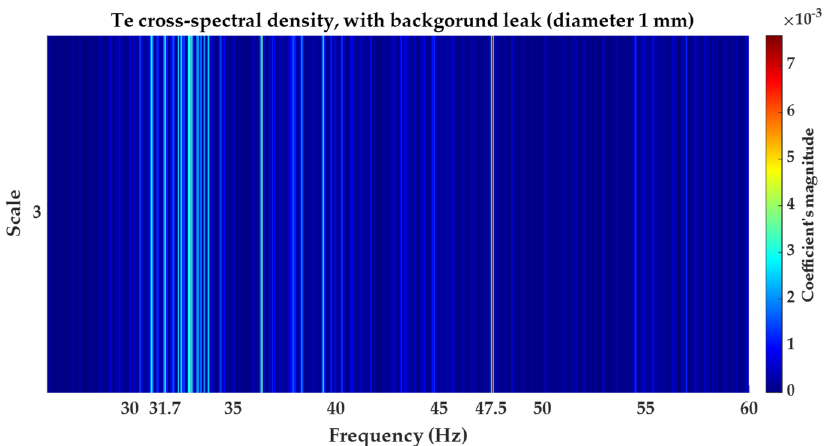
Figure 14 . 𝒯 (cid:3032) cross-spectral density in Scale 3 , with background leak ( 1 mm in diameter) and flow rate 33.7 mL/s .